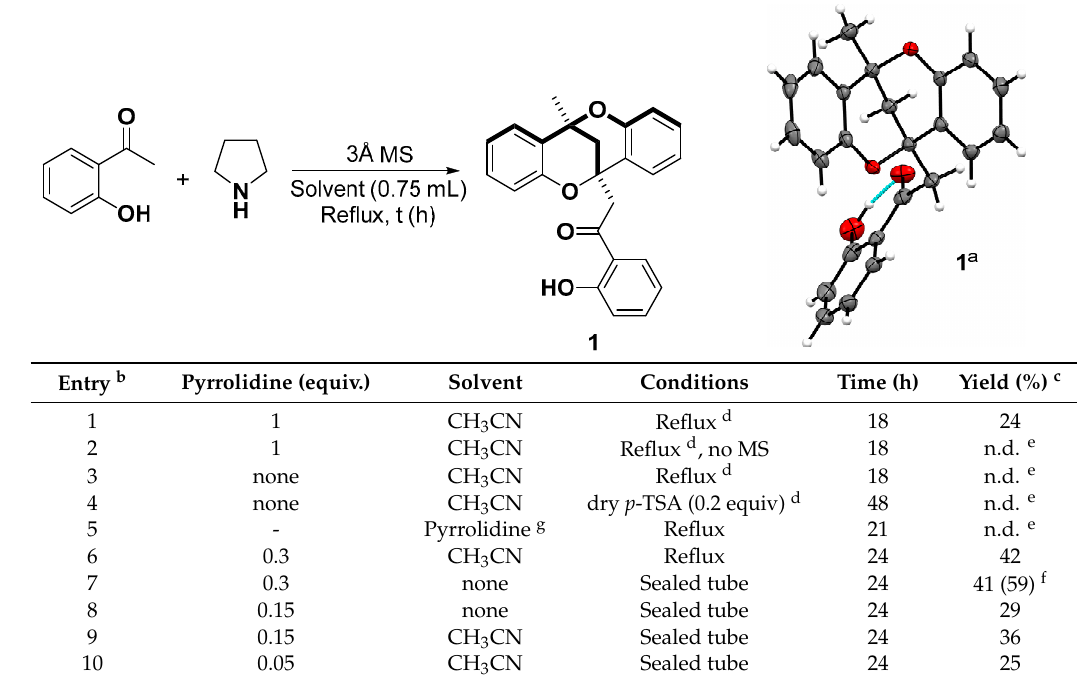
Table 1. Initial optimization of reaction conditions.